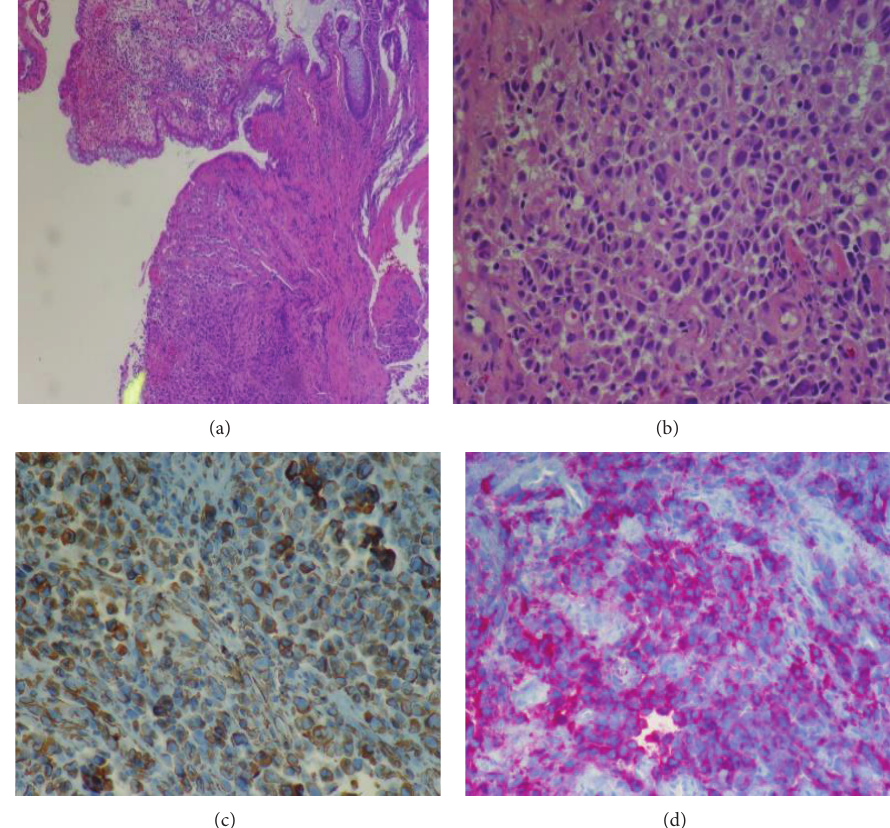
Figure 3: (a) Hematoxylin-eosin stain of melanoma in terminal ileum. (b) Hematoxylin-eosin stain of melanoma in terminal ileum, original magnification × 400. (c) Specimen stained with c-kit immunohistochemistry, original magnification × 400. (d) Specimen stained with HMB 45+ antibody original magnification ×